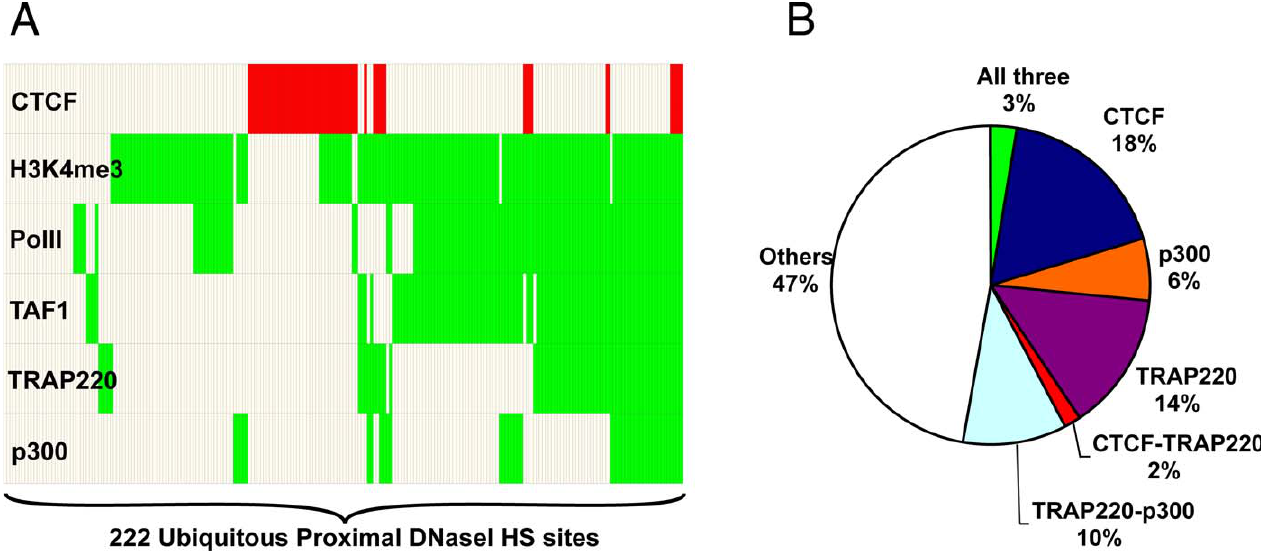
Figure 3. Ubiquitous Proximal DNaseI HS Sites Overlap with Known Factors (A) Chart identifying the different factors that overlap 222 ubiquitous DNaseI HS sites that map to TSS, including RNA Pol II, TAF1, TRAP220, p300, CTCF, and the H3K4me3 histone mark. Red indicates overlap with CTCF, green indicates overlap with other marks, and unfilled boxes represent no overlap. (B) Pie chart representing the percentage of ubiquitous DNaseI HS sites that overlap with various factors (histone modifications not shown for clarity purposes).